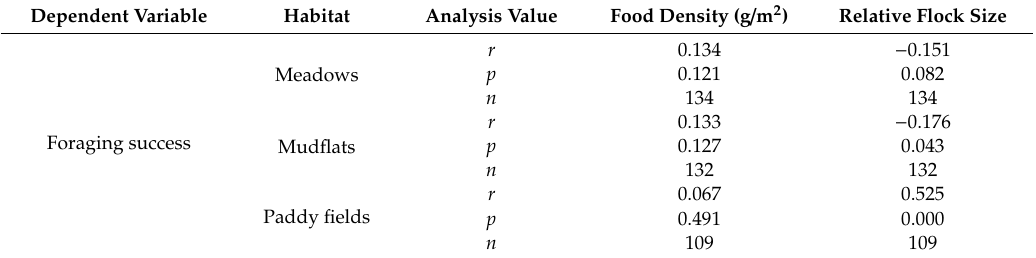
Table 1. The correlation between the foraging success rate of hooded crane and the influencing factors at Shengjin